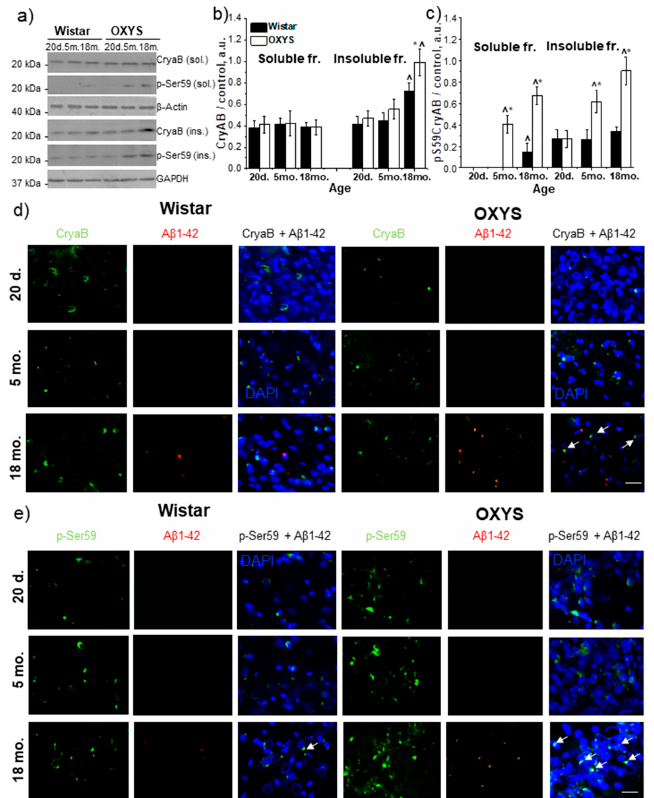
Figure 3. The amounts of proteins CryaB and p-Ser59-CryaB in the hippocampus of 20-day-old and 5- and 18-month-old Wistar and OXYS rats. ( a ) Representative western blots of total and phosphorylated CryaB in the detergent-soluble and detergent-insoluble fractions from the hippocampus of Wistar and OXYS rats. Graphical presentation shows the relative protein content of CryaB ( b ) and p-Ser59-CryaB ( c ) in Wistar and OXYS rats’ hippocampi at different ages after normalization of detergent-soluble fraction data to β -actin and detergent-insoluble fraction data to GAPDH. Data are presented as mean ± SEM of five independent experiments. Immunostaining of CryaB ( d ) and p-Ser59-CryaB ( e ) in the hippocampus of 20-day-old and 5- and 18-month-old Wistar and OXYS rats. The nuclei were stained with DAPI (blue). Scale bars, 25 μ m. * Statistically significant differences between the strains of the same age; ^ significant differences from the previous age within a strain ( p < 0.05). The p-Ser59-CryaB protein was found in both protein fractions in Wistar and OXYS rats (Figure 3a,c). According to ANOVA, p-Ser59-CryaB content in the detergent-soluble fraction was affected by genotype (F 1,24 = 210.8, p < 0.01) and age (F 2,24 = 122.6, p < 0.01), and there was an interaction effect (F 2,24 = 55.4, p < 0.01). We did not detect the p-Ser59-CryaB protein in the detergent-soluble fraction from the hippocampi of 20-day-old Wistar and OXYS rats and of 5-month-old Wistar rats (Figure 3a,c). In